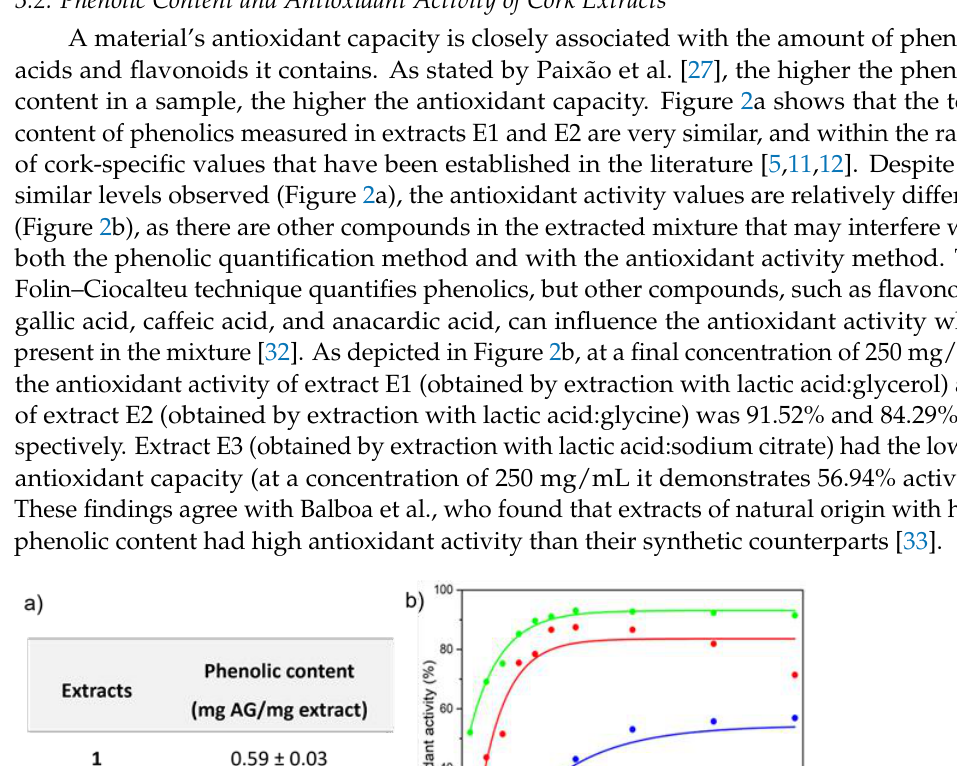
Figure 1. Extract concentrations (g/L) obtained from cork after extraction with NADES using a sealed system (0.7 g cork; 5 mL solvent; 100 °C; 6 h; three cycles using the sealed system).